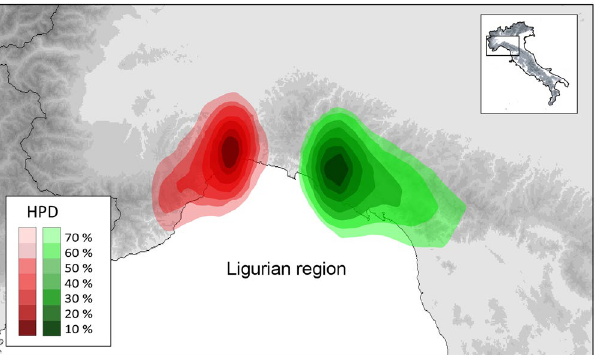
Figure 5. Ancestral areas of the two main genetic lineages of Ichthyosaura alpestris at their respective times to the most recent common ancestor (TMRCAs) based on Bayesian phylogeographical analyses conducted independently for both lineages on mtDNA. Polygons represent the highest posterior density (HPD) regions of the geographical locations at 10% to 70% probabilities. The map was drawn using the software Canvas 11 (ACD Systems of America,